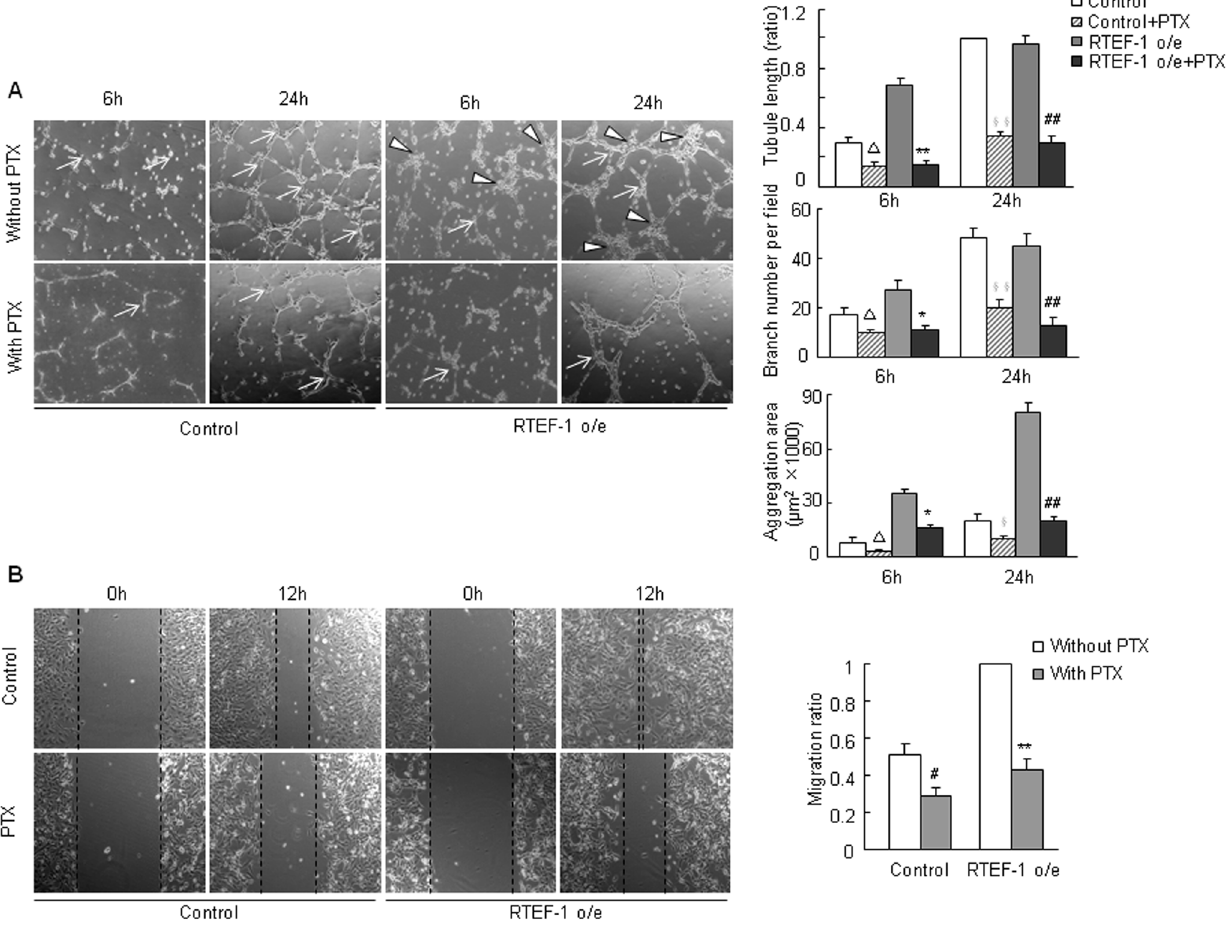
Figure 4. PTX inhibits RTEF-1 driven endothelial cell aggregation and migration. A. PTX decreased RTEF-1 driven endothelial cell tube formation and aggregation. ( D = p , 0.05, vs control HMEC-1 at 6 h Matrigel; *= p , 0.05, vs RTEF-1 o/e HMEC-1 at 6 h Matrigel; **= p , 0.01, vs RTEF- 1 o/e HMEC-1 at 6 h Matrigel; 1 = p , 0.05, vs control HMEC-1 at 24 h Matrigel; 11 =p , 0.01, vs control HMEC-1 at 24 h Matrigel; ## =p , 0.01, vs RTEF-1 o/e HMEC-1 at 24 h Matrigel; Triangle: aggregation area; Arrow: branch) B. PTX retarded RTEF-1 driven endothelial cell migration ( # = p , 0.05, vs control HMEC-1 without PTX treatment; **= p , 0.01, vs RTEF-1 o/e HMEC-1 without PTX treatment). The results were quantified based on three experiments and are presented as mean 6